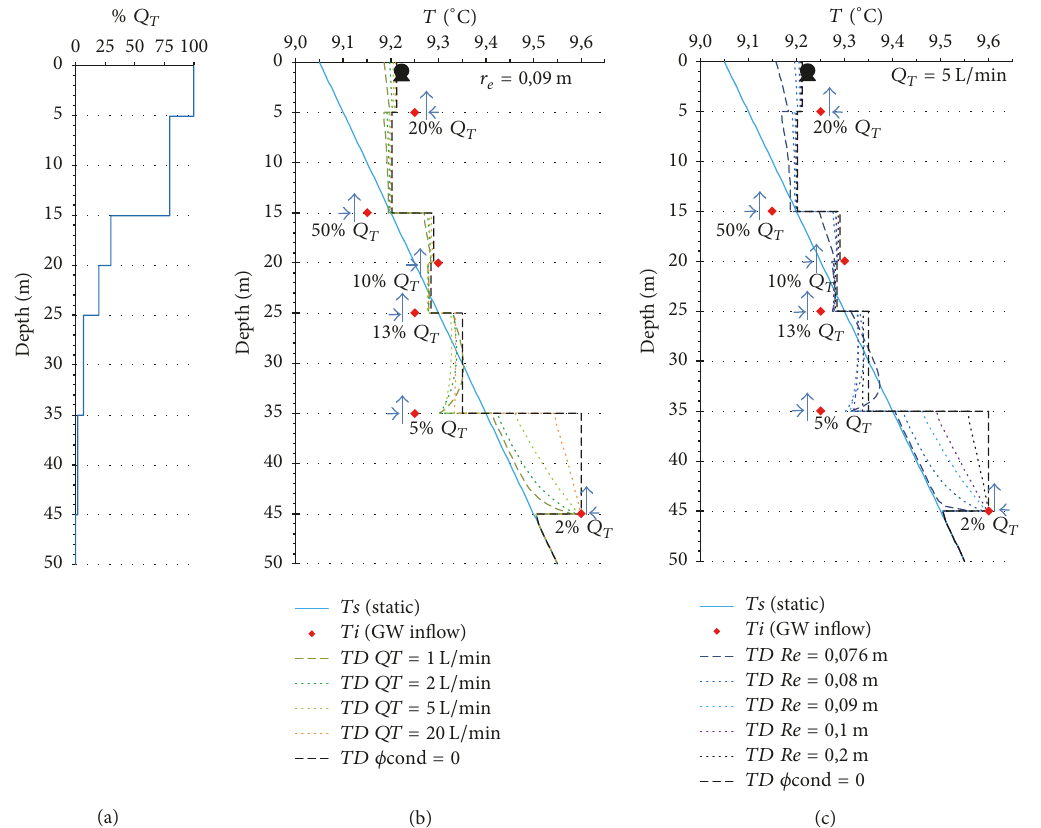
Figure 4: Dynamic depth-temperature profiles modelled with the heat